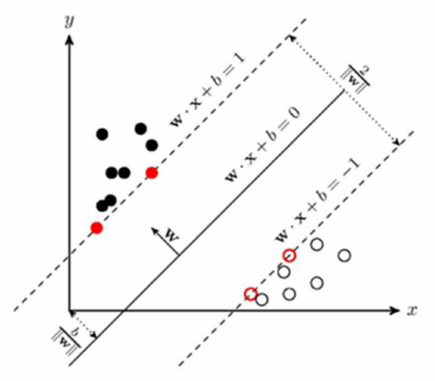
Figure 1. Support vector machine hyperplane conceptual